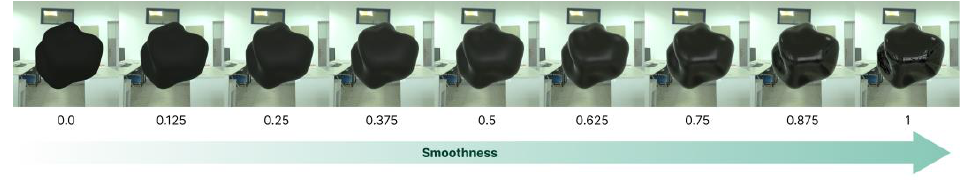
Figure 1. The stimuli within the Virtual group exhibit PBR smoothness parameters that are uni- formly distributed between 0 and